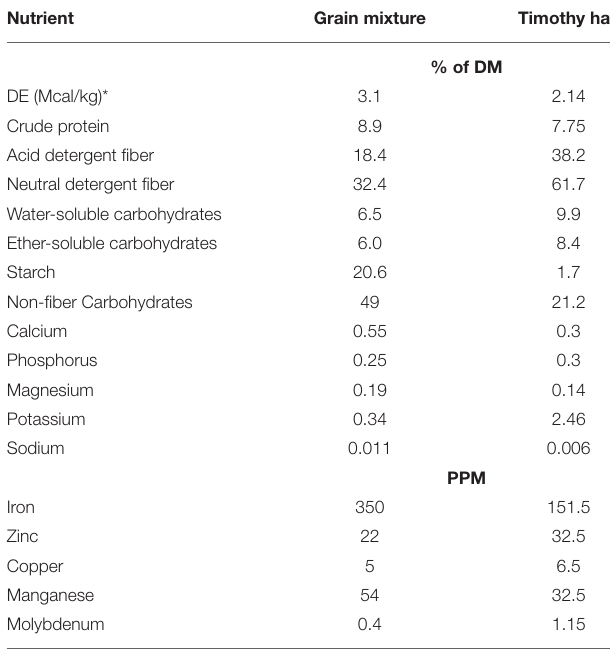
TABLE 2 | Nutrient composition of the daily grain mixture and timothy hay on dry matter basis. Nutrient Grain